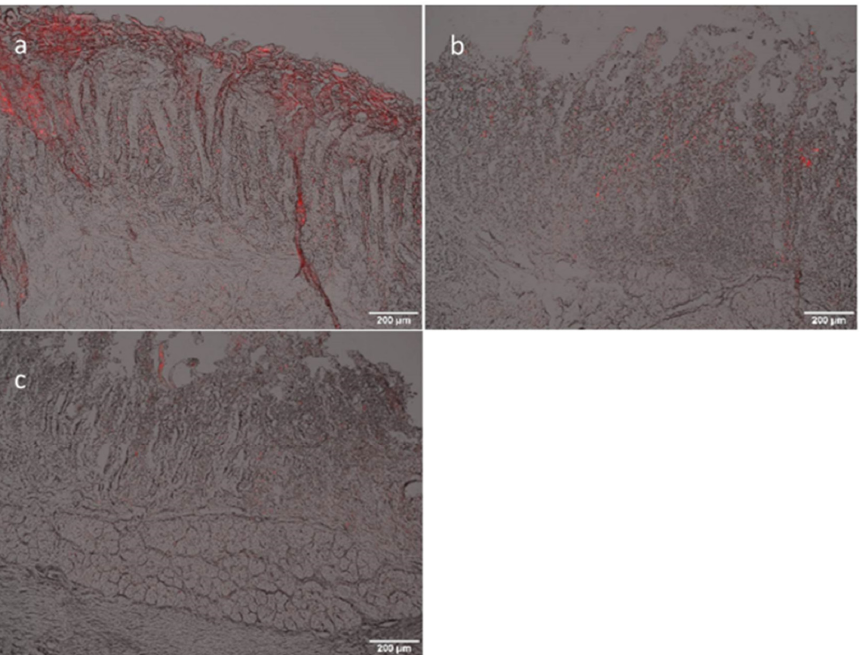
Figure 8. Fluorescence microscopy micrographs of a histological section of porcine small intestinal mucosa; the red fluorescence signal shows rhodamine B labelled particles; ( a ) thiolated Lip-SeNPs; ( b ) uncoated Lip-SeNPs; ( c ) blank. The reddish background color comes from the auto-fluorescence of the mucosa; scale bar: 200 µm.